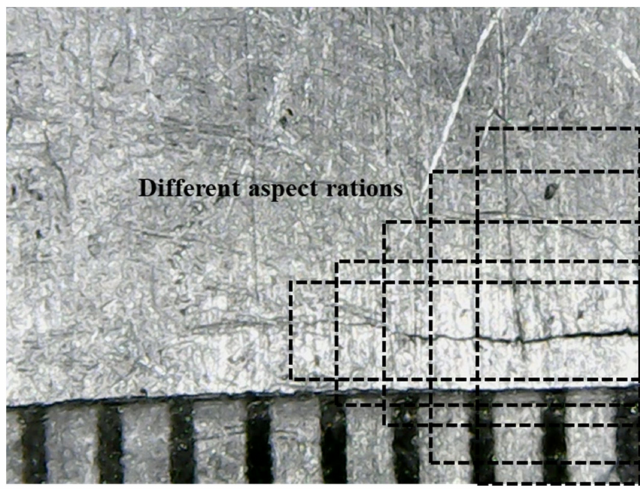
Figure 6. Different aspect ratios for crack